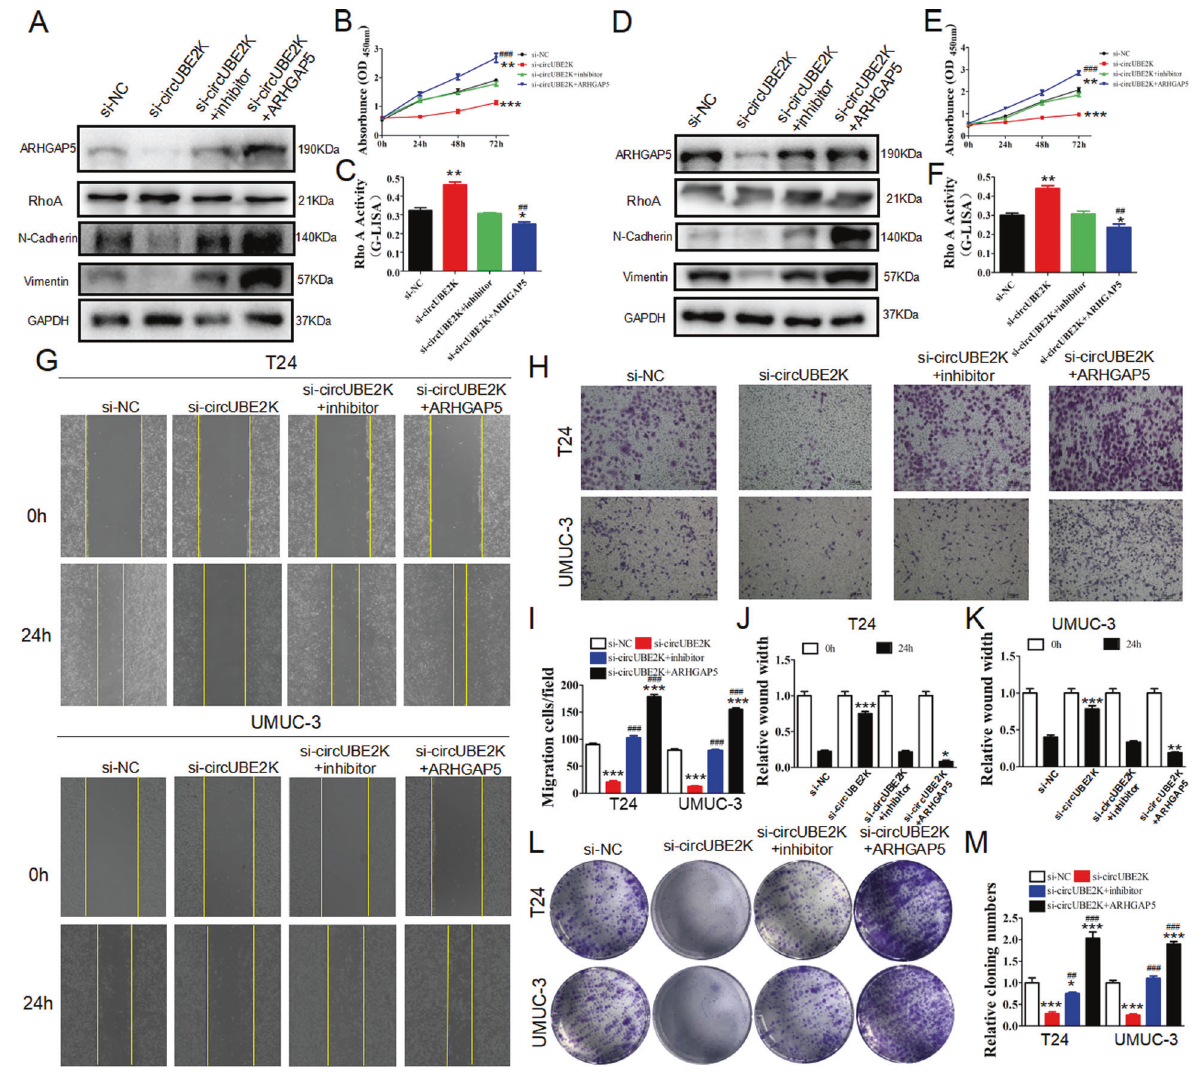
Cell Death and Disease (2022)